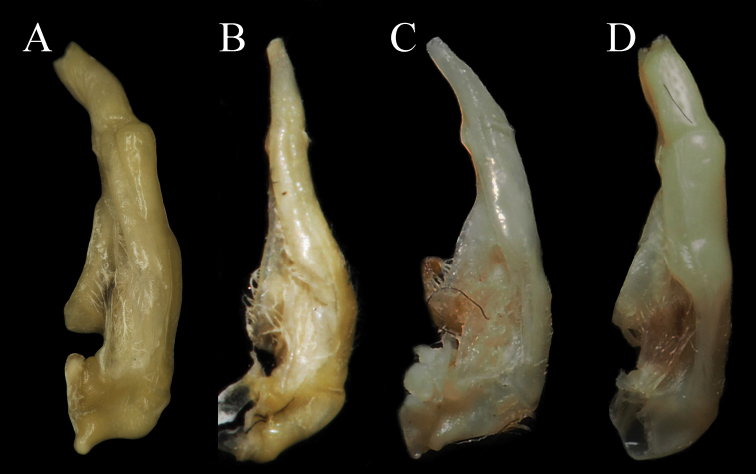
Left G1s. AMediapotamon
liboense sp. nov. NCU MCP, 24.2 × 19.6 mm BM.
angustipedum (Dai & Song, 1982), IZCAS CB 00995, 15.3 × 13.1 mm CM.
leishanense Dai, 1995, IZCAS CB 05181,14.8 × 11.5 mm DDaipotamon
minos, Ng & Trontelj, 1996, NCU MCP 195501, 20.1 × 16.3 mm.